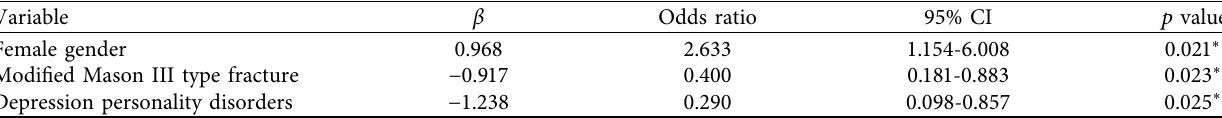
Table 5: Logistic regression for variables predictive factors of occurrence of CRPS